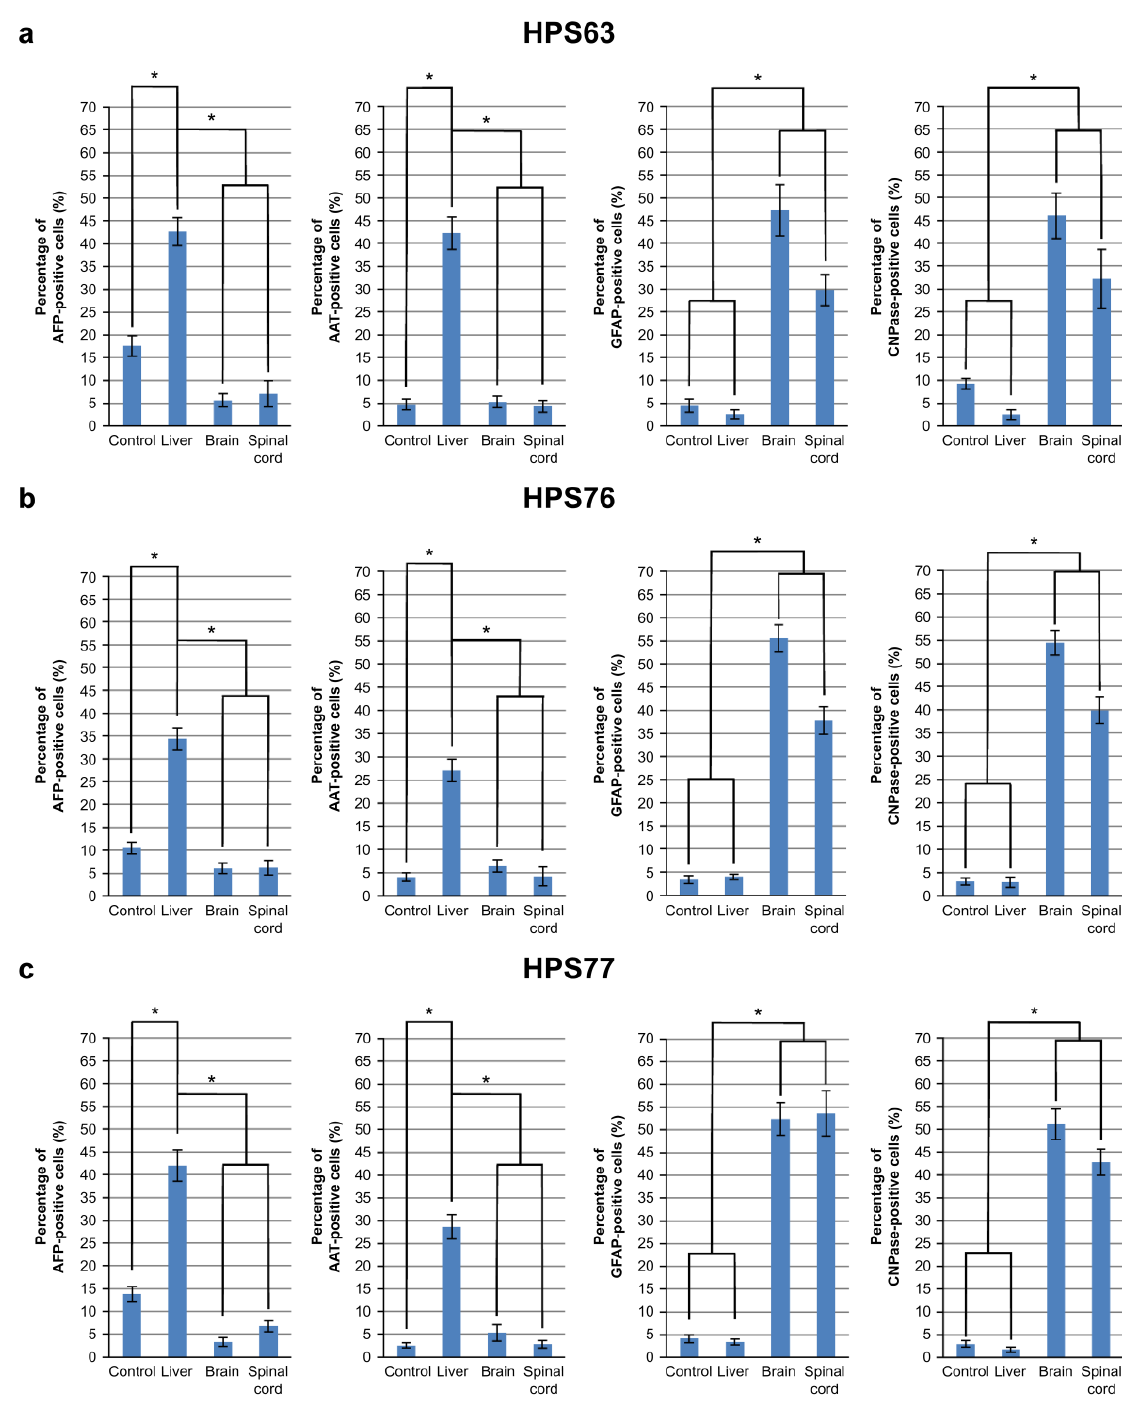
Figure 3. Protein expression of cell markers in differentiated iPSCs. The percentages of AFP-, AAT-, GFAP-, and CNPase-positive iPSCs in the selected fields of interest. ( a ) The HPS63 cultured on frozen sections of the liver exhibited significantly more AFP- and AAT-positive cells than the control group and the HPS63 cultured on sections of the brain and the spinal cord. The HPS63 cultured on sections of the brain and the spinal cord exhibited significantly more GFAP- and CNPase-positive cells than the control group and the HPS63 cultured on sections of the liver. ( b ) HPS76 exhibited a pattern similar to hOF-iPSCs and HPS63. ( c ) HPS77 also exhibited a pattern similar to hOF-iPSCs, HPS63, and HPS76. Thus, all the iPSCs exhibited similar expression patterns. Note: * p < 0.05.